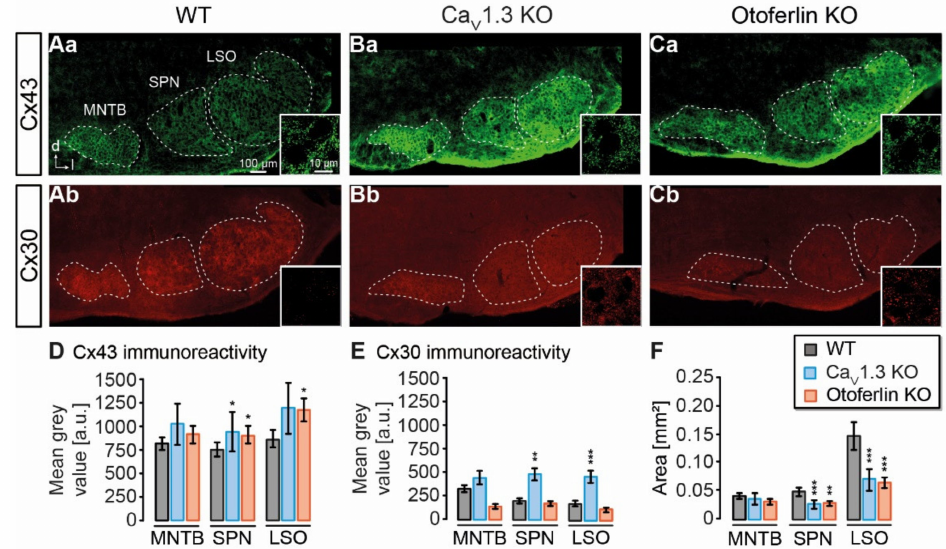
Figure 1. Expression of astrocyte-related connexins in the superior olivary complex (SOC). ( A – C ), widefield images showing immunoreactivity of Cx43 and Cx30 in the mouse SOC from the wild type (WT) ( Aa (Cx43), Ab (Cx30)), CaV1.3 knock-out (KO) ( Ba (Cx43), Bb (Cx30)) and otoferlin KO ( Ca (Cx43), Cb (Cx30)). Regions used for mean grey value und area analysis are indicated with dashed lines. Insets: Close ups showing the punctate Cx labeling in the lateral superior olive (LSO) center. ( D ), mean grey values of Cx43 immunofluorescence. Cx43 levels were increased in the SPN from both KO models and in the LSO from otoferlin KO. ( E ), mean grey values of Cx30 immunofluorescence. Cx30 was elevated in the SPN and LSO of Ca V 1.3 KO. ( F ), area of nuclei in the SOC. SPN and LSO from both KO models exhibited a reduced area compared to the WT. Mean grey values were background subtracted. ( D – F ) show mean ± SD. Significance levels in panels ( D – F ) were Šid á k corrected for two comparisons. The sample size is given in the text of Section 4.2. * p < 0.025, ** p < 0.005, *** p <